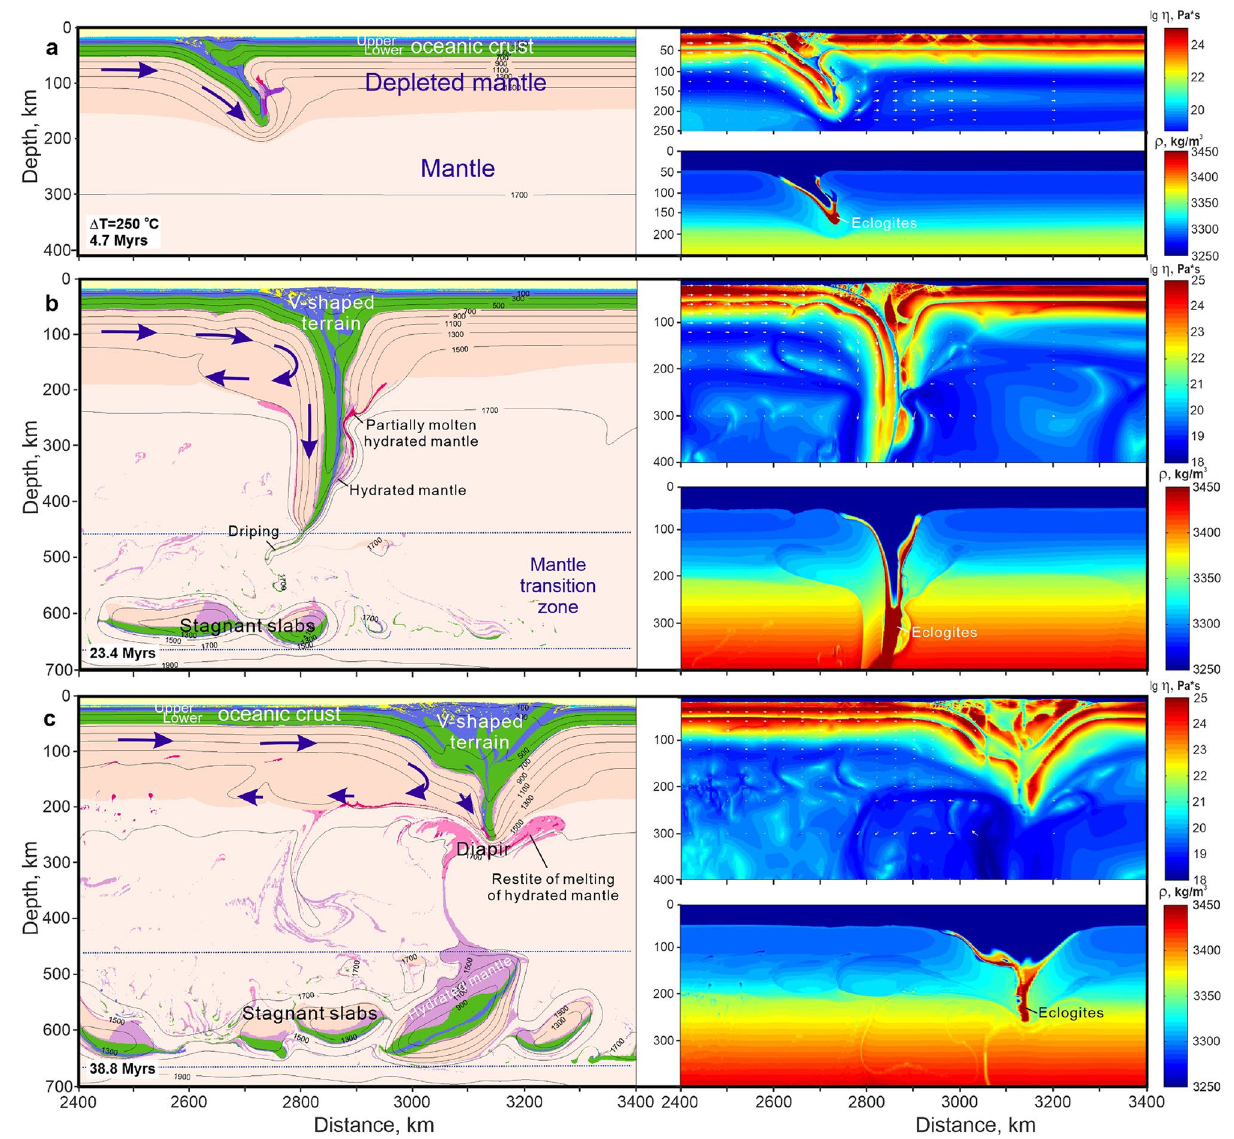
Figure 4. Formation of an accretionary V-shaped terrain and over-thickened melt-depleted mantle during two- sided subduction at constant convergence velocity of 5 cm/year and elevated mantle temperature ΔT = 250 °C (T p = 1550 °C). ( a ) Flat ocean–ocean subduction with highly depleted mantle (4.7 myrs from the beginning of the experiment). Eclogitization of the subducting oceanic crust (density ≥ 3450 kg/m 3 ) occurs at ~ 150 km depth. ( b ) Two-sided vertical subduction with V-shaped accretionary terrain atop over-thickened depleted mantle under the left-hand plate (23.4 Myr from the beginning of the experiment). Note the reverse viscous flow of the depleted mantle detached from the left-hand slab. Eclogitization of the subducting oceanic crust (density ≥ 3450 kg/m 3 ) occurs at ~ 250 km depth. ( c ) Large V-shaped accretionary terrain and voluminous stagnant slabs in the mantle transition zone (38.8 Myr from the beginning of the experiment). Density and effective viscosity fields with velocity vectors are shown for each stage as separate panels at the bottom right and at the top right, respectively. Dotted dark-blue lines in b and c of the left column indicate upper and lower boundaries of the mantle transition zone. Arrows show direction of plate motion (not to scale) and viscous flow of the depleted mantle. The colour key is as in Fig. 2. Viscosity of the mantle is intrinsically dependent on pressure, temperature, degree of depletion and presence of fluid/melt (see “Method”). The rheological transition between the rigid lithospheric and low-viscosity asthenospheric (sublithospheric) mantle approximately corresponds to the 1300 °C isotherm. Prescribed velocity of the left-hand plate is 5